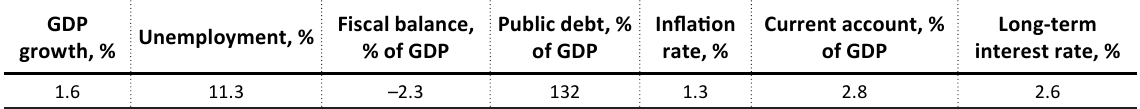
Table 3. Italy macro-economic indicators in 2017